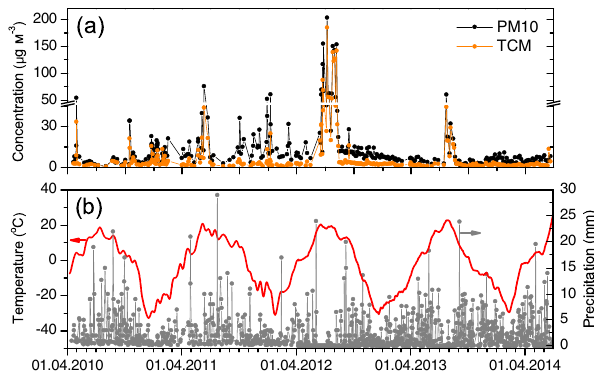
Figure 1. Seasonal and interannual variations in the aerosol par- ticulate matter (PM 10 ) and TCM concentrations (a) and of daily- averaged meteorological parameters (b) : temperature – red line; precipitations – grey line and